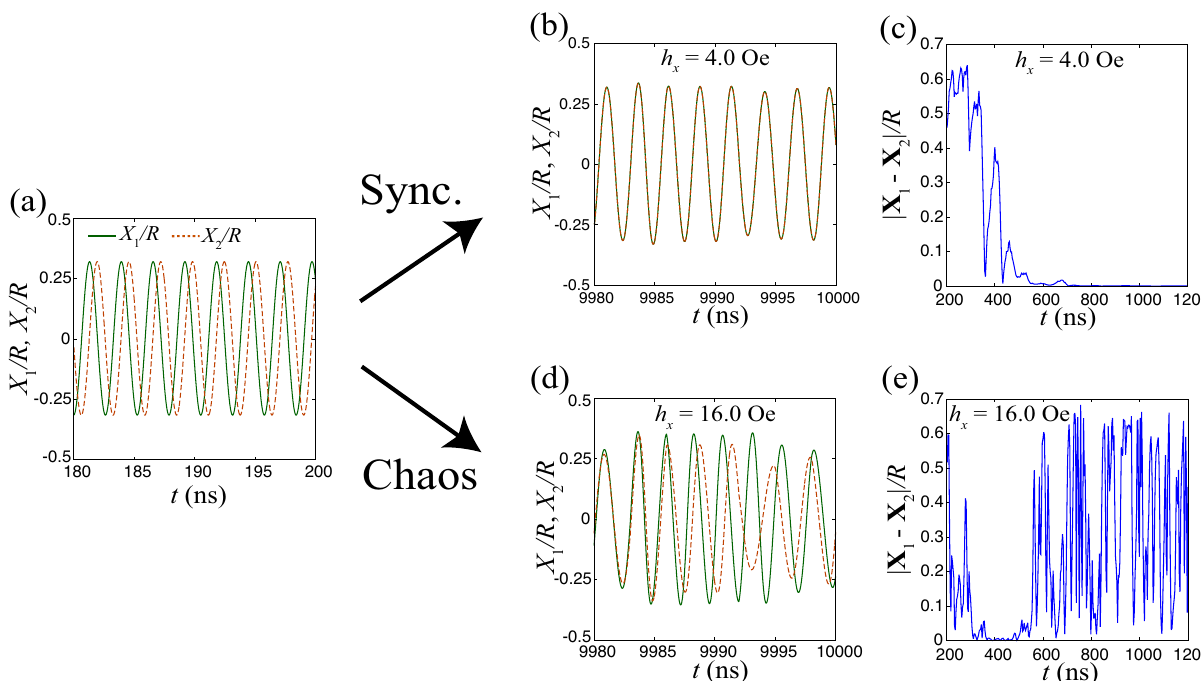
Figure 2. ( a ) Temporal dynamics of two X / R s, denoted as X 1 / R and X 2 / R , with slightly different initial condition. Here, the random magnetic field is not injected yet. ( b ) Temporal dynamics of X 1 / R and X 2 / R after injection of the input signal. The input signal is relatively weak ( h x = 4 Oe). ( c ) Difference between X / R s, | X 1 − X 2 | / R , for a small input strength. ( d ) Temporal dynamics of X 1 / R and X 2 / R after injection of the input signal. The input signal is relatively strong ( h x = 16 Oe). ( e ) Difference between X / R s, | X 1 − X 2 | / R , for a large input